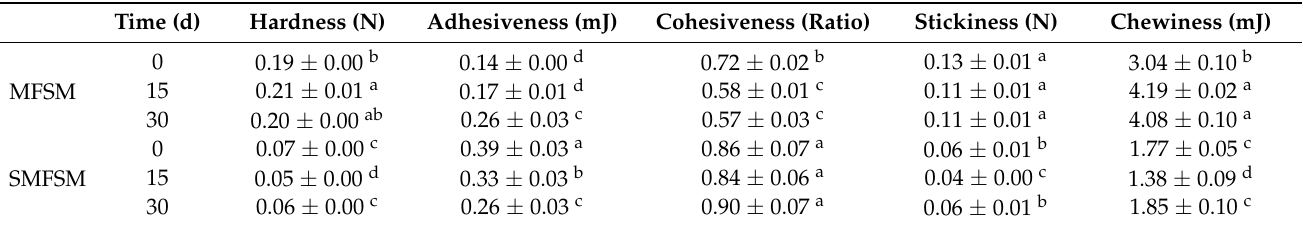
Table 2. Effects of different mixed fermentation methods on the texture characteristics of